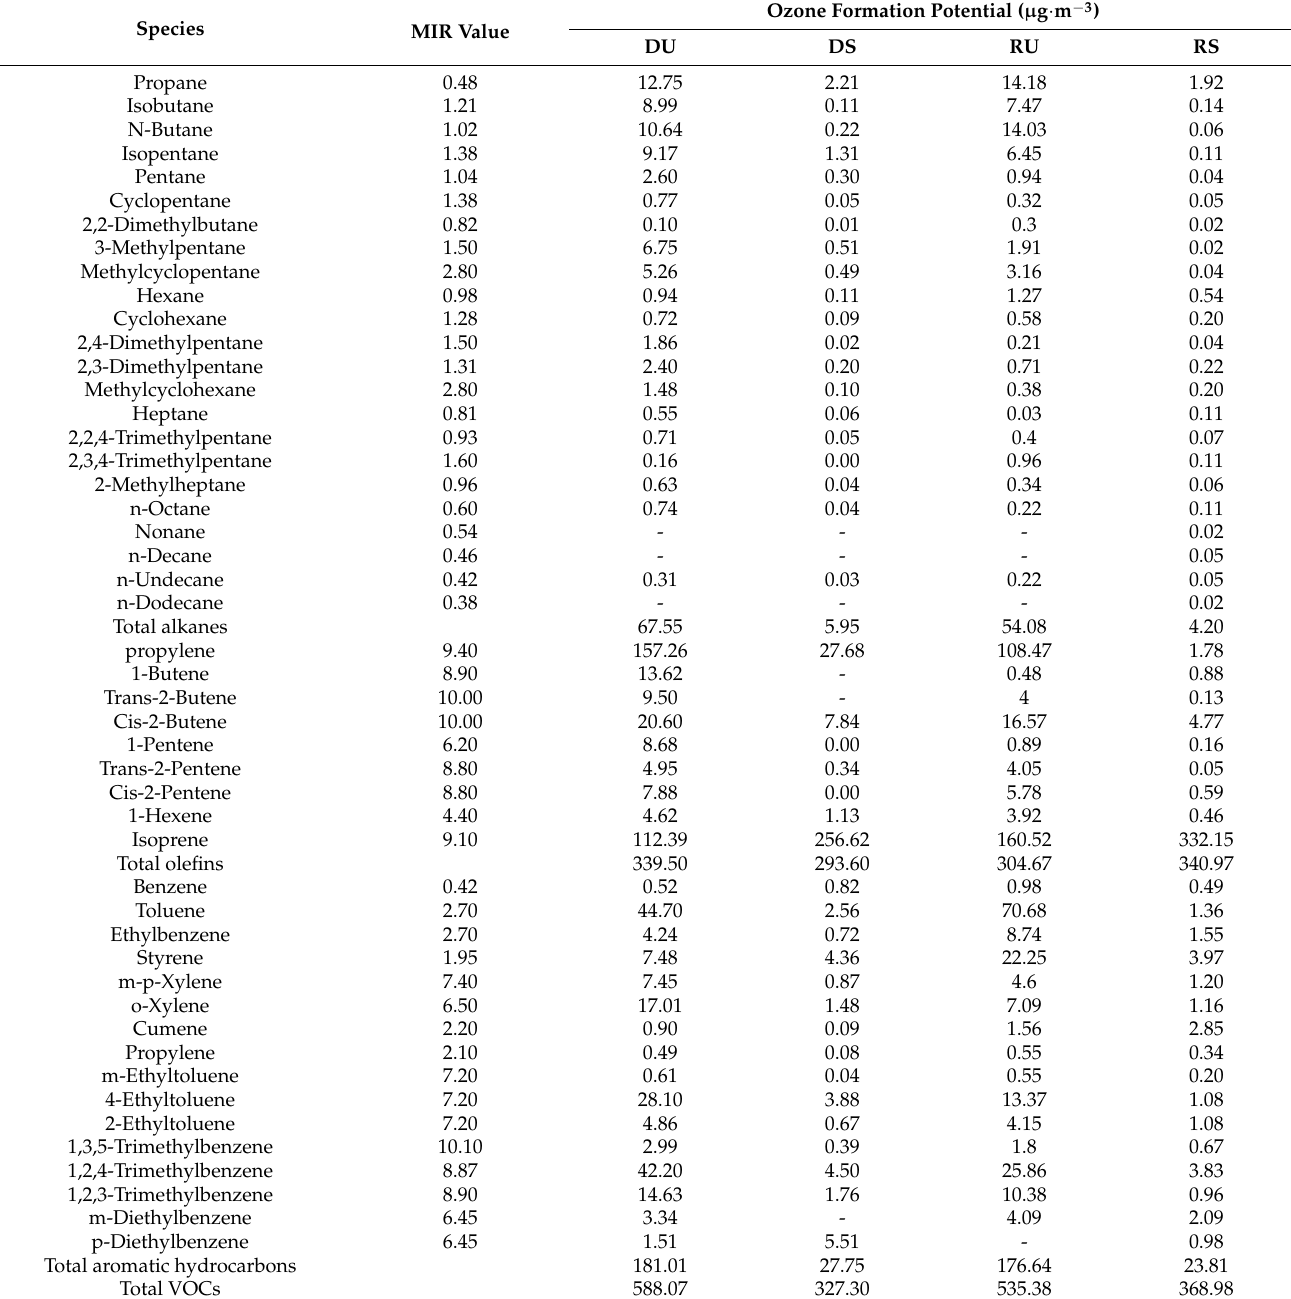
Table 2. Potential Ozone Formation of VOCs in